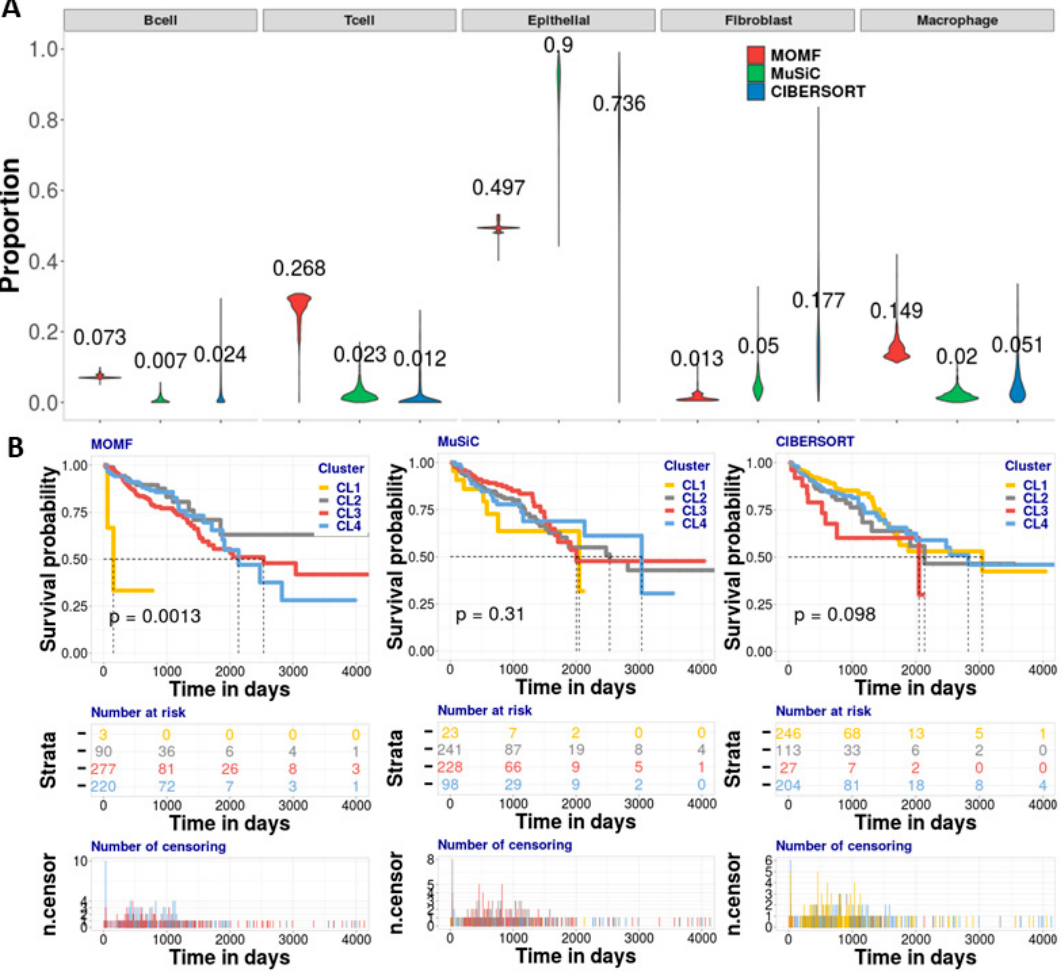
Figure 4. Analyzing CRC bulk RNA-seq data with colorectal cancer scRNA-seq data. ( A ) The violin plot is to show the e ff ect proportion of each cell type from three di ff erent methods. We found that the epithelial, T and macrophage cells are enriched by MOMF, which means that the two cell types potentially contribute to the survival of CRC. ( B ) The KM plots are used to show the survival analysis for four clusters from the TCGA bulk data. We used log-rank test to compare the distributions of four clusters. MOMF grouped the CRC samples into four subtypes ( p -value = 0.0013). The cluster CL1 shows the poor-prognosis. Number at risk in the table shows the number of survival individuals at each 1,000 days. Number of censoring in the table shows censoring time of each individual. The numbers labeled in di ff erent colors in the two tables indicate the di ff erent